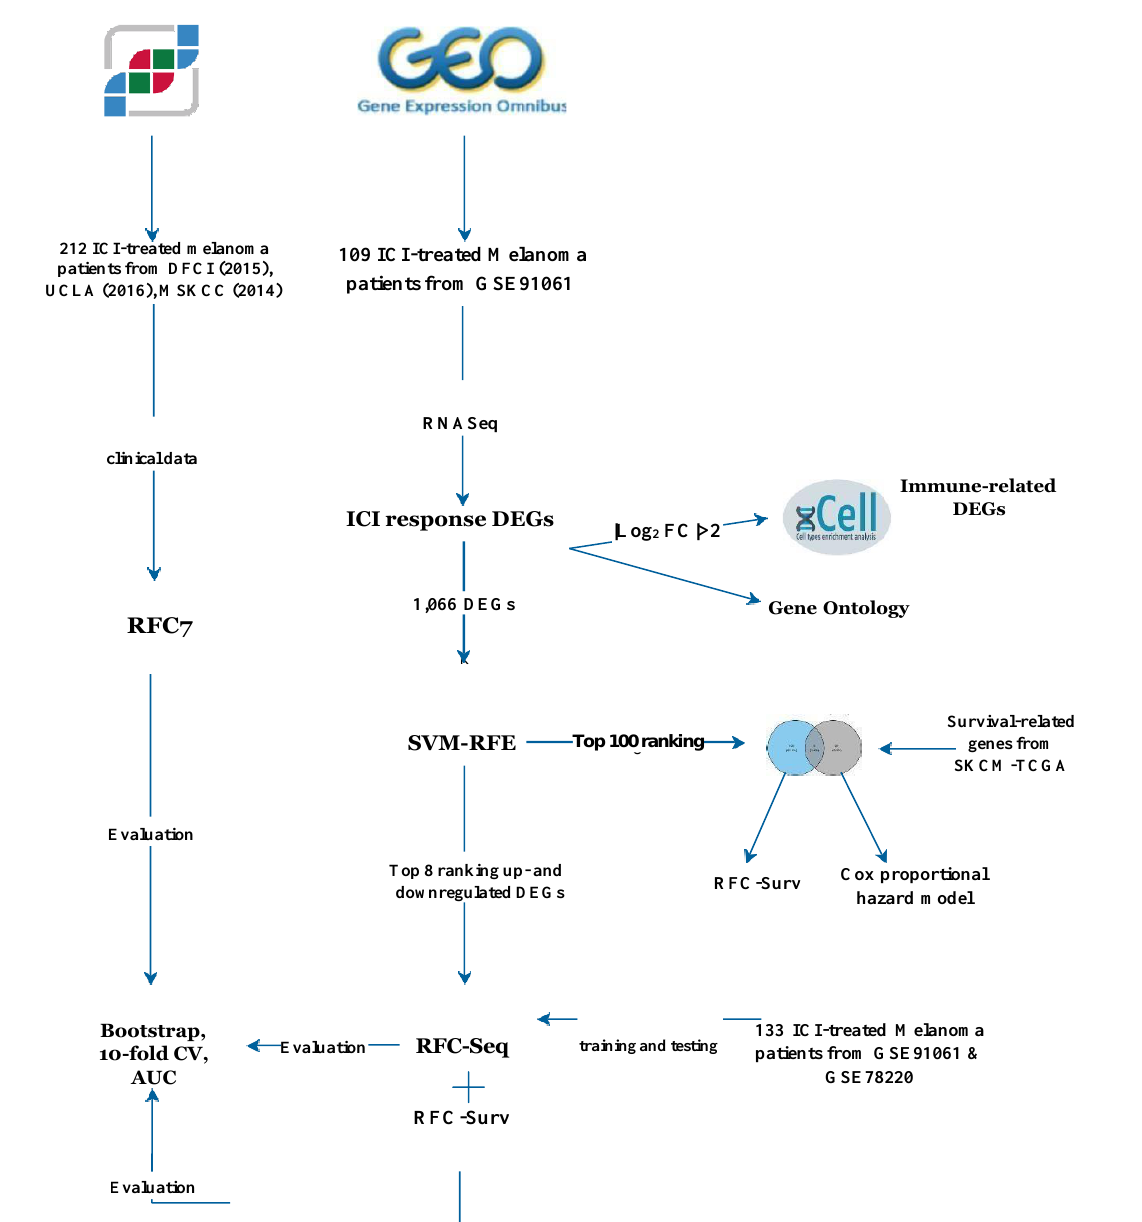
Figure 1. Workflow of the study . Four RFC models were built, a clinical and genomic model (RFC7)